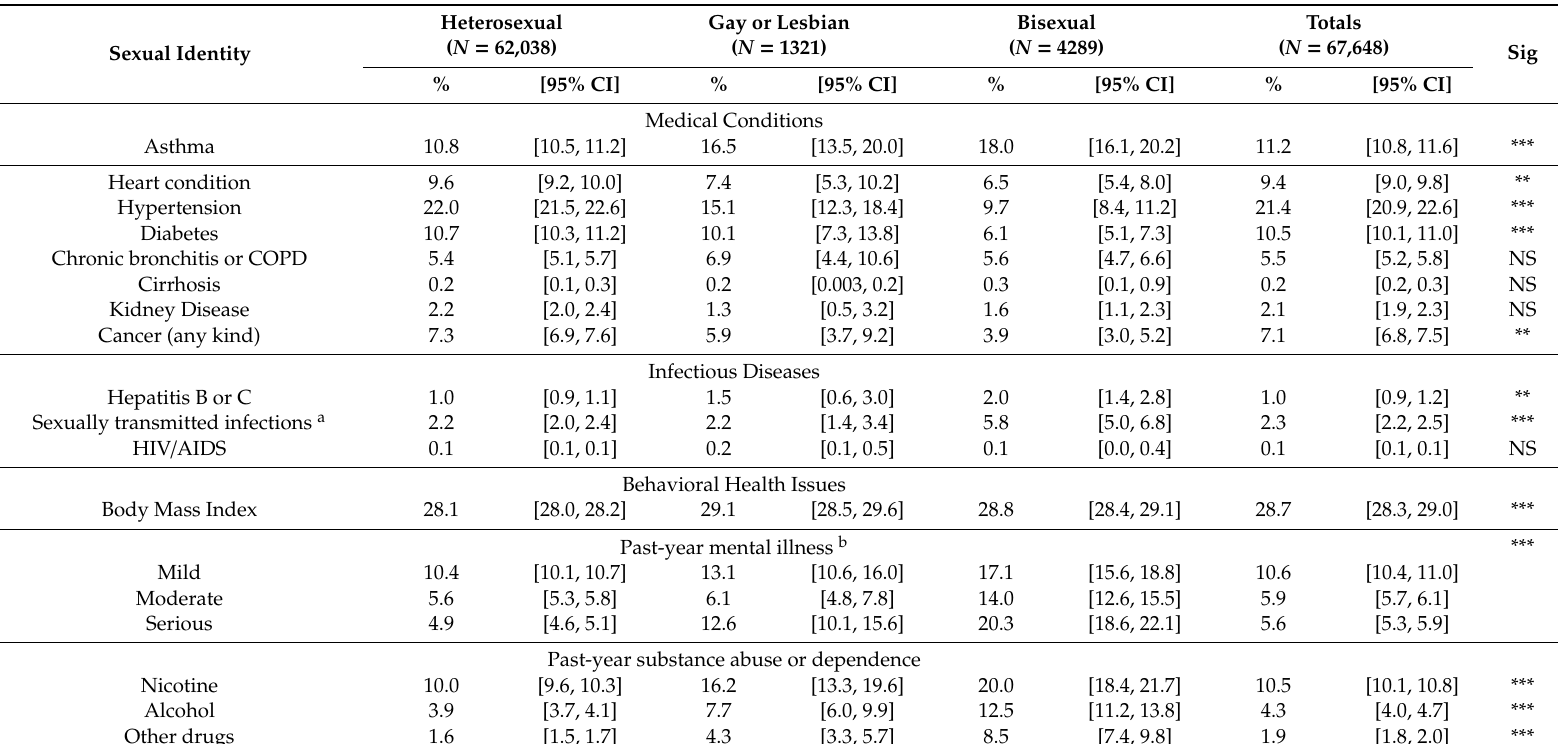
Table 2. Bivariate Comparisons of the Lifetime Prevalence of Medical Conditions, Infectious Diseases, and Behavioral Health Issues by Sexual Identity.